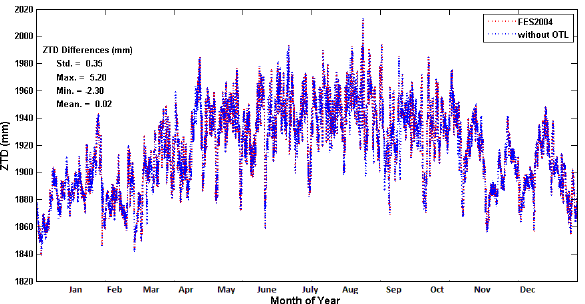
Figure 3. GNSS-estimated PWV time series at ADAN station